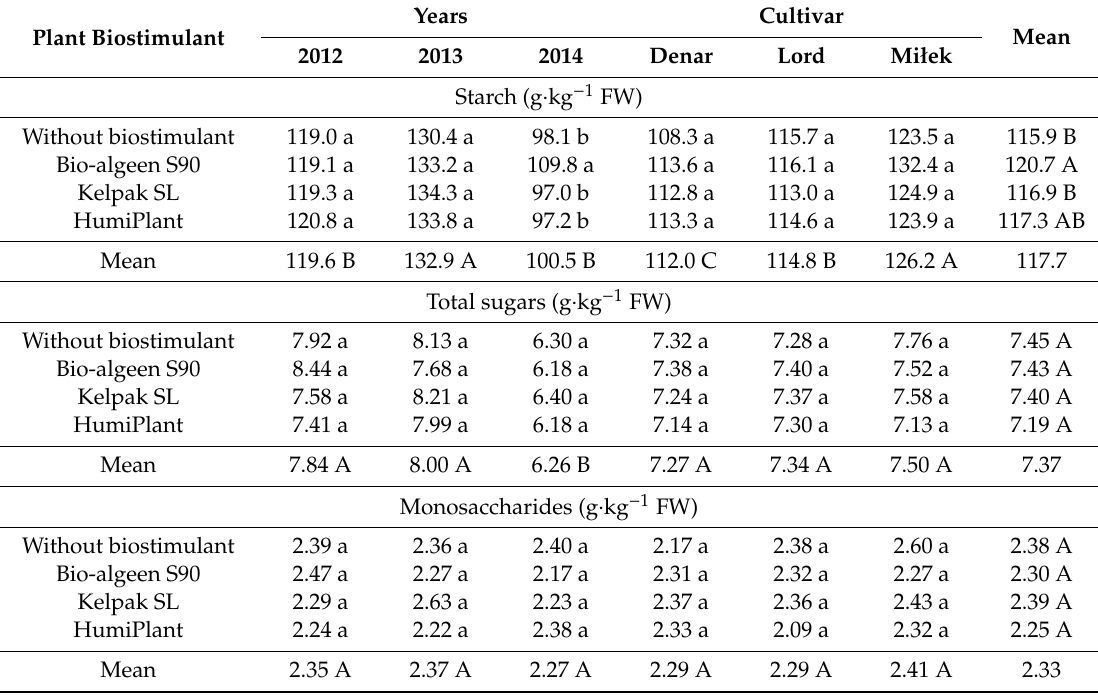
Table 5. Carbohydrates content in potato